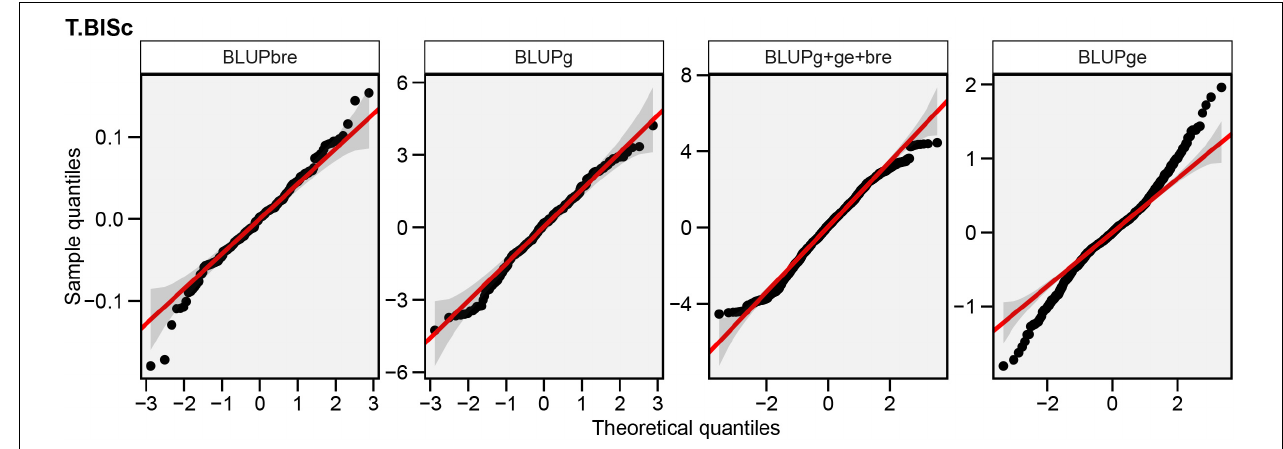
FIGURE 4 | Normal Q-Q plots showing the distribution of random effects associated with block within replication (BLUPbre), genotype (BLUPg), total phenotypic effects (BLUPg + ge + bre), and GEI (BLUPge) depicting 95% confidence level for adjustment to normality recorded across environments.